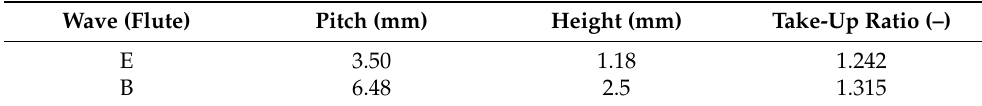
Table 1. The geometrical features of both corrugated layers of EB-650.